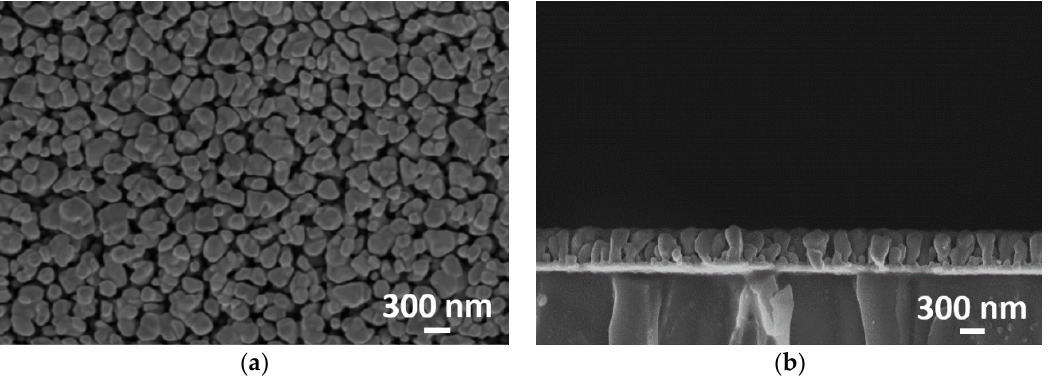
Figure 2. ( a ) Top-view and ( b ) cross-sectional view of the scanning electron microscopy images of the fabricated Ag vertical nanorods metal-enhanced fluorescence (MEF) substrate with a nanorod length of 500 nm.